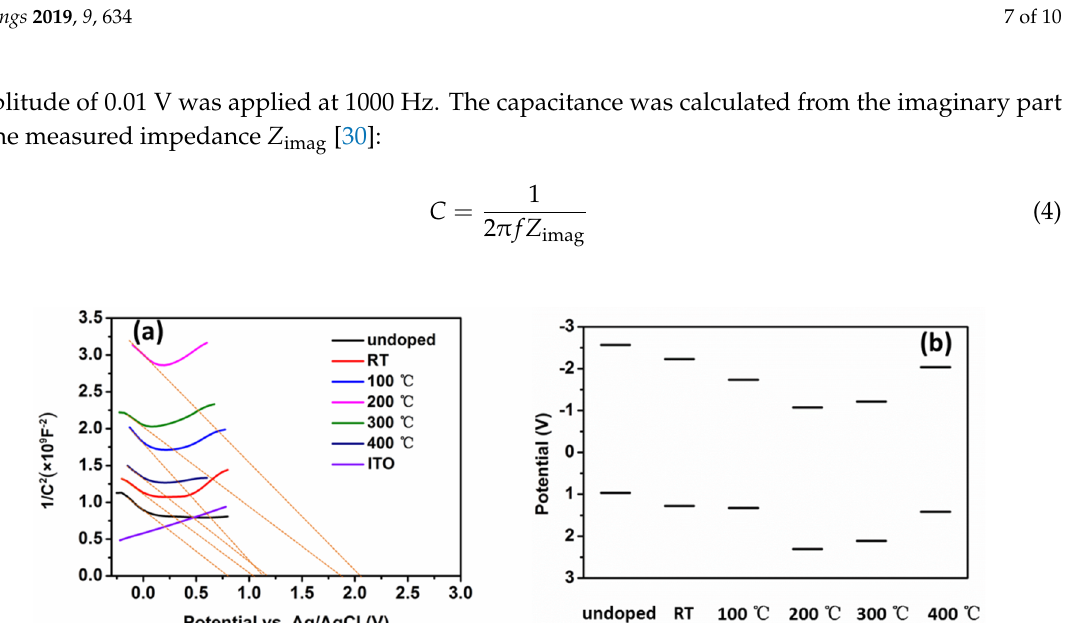
Figure 10. Impedance of samples deposited at different substrate temperatures.